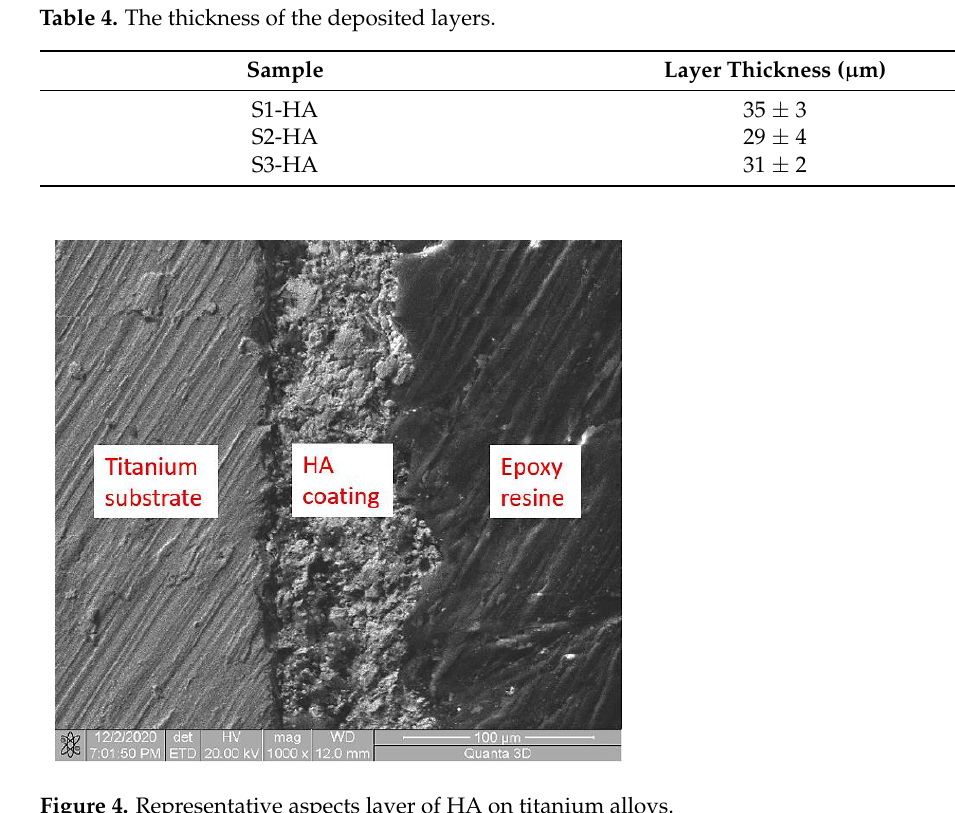
Figure 4. Representative aspects layer of HA on titanium alloys.